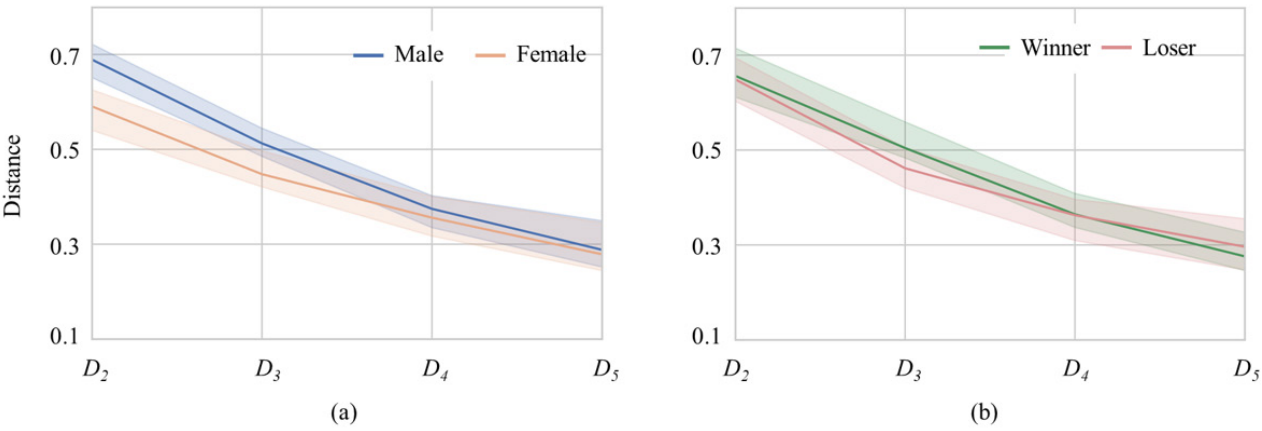
Figure 2. Distances between the observed losing rates and the expected losing rates at each shot number. D shot, was calculated from the i-th and subsequent shots. The median of the scoring rate and the losing rate was calculated for each gender and for winners and losers. The shaded area denotes the 95% confidence